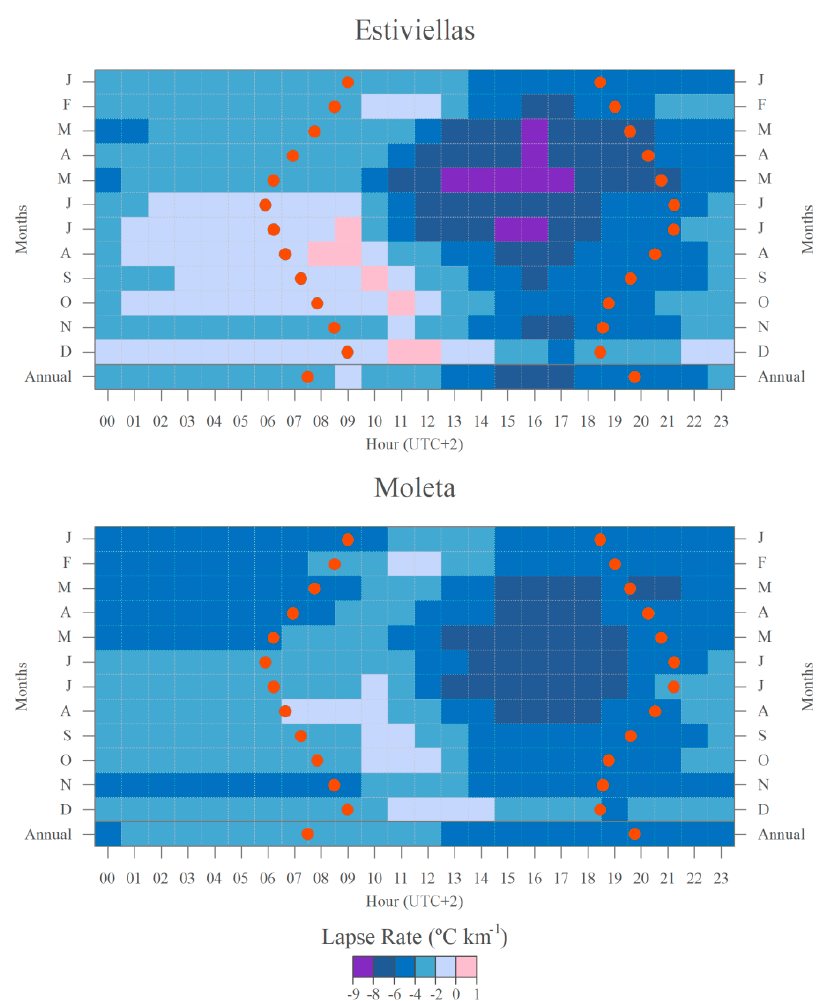
Figure 5. Mean hourly lapse rates (LRs, measured in °C km − 1 ) for the Estiviellas and Moleta slopes by month. Red dots represent the sunrise/sunset time without topography effects, calculated for the 15th day of each month, and for equinoctial day in the Annual row.